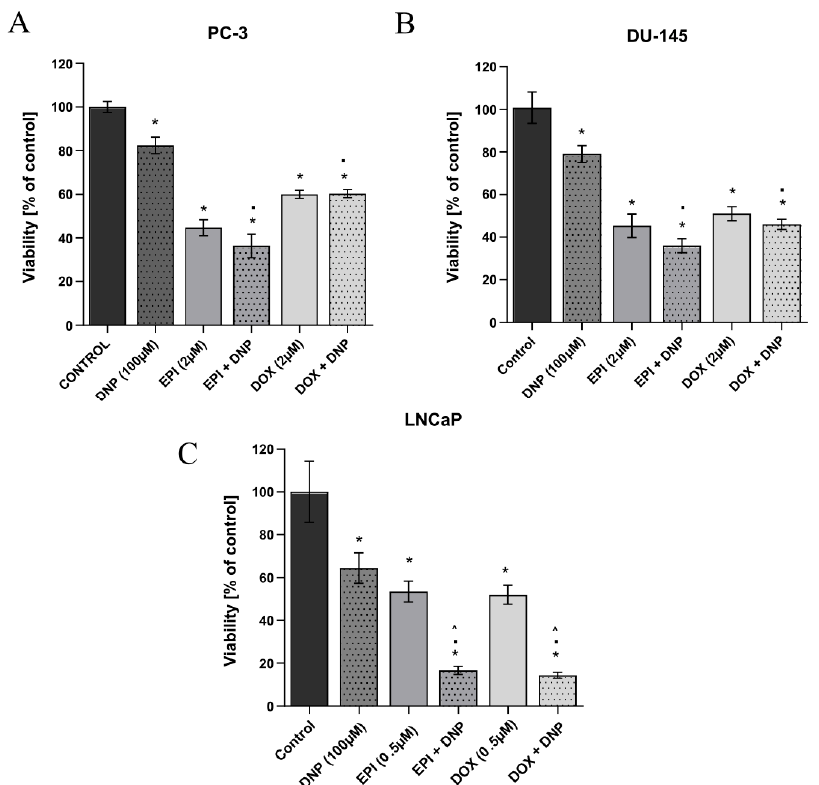
Figure 3. Prostate cancer cell lines ( A ) PC-3, ( B ) DU-145, ( C ) LNCaP viability (% of control) based on MTT assay. The cells were treated with 2,4-DNP and EPI (epirubicin), DOX (doxorubicin), or combined (2,4-DNP + EPI, 2,4-DNP + DOX) for 48 h. The values obtained from three independent experiments were presented as mean ± SD. * p < 0.05 vs. control, ▪ p < 0.05 vs. 2,4-DNP, ^ p < 0.05 vs. DOX, EPI. Molecules 2022 , 27 , 7227